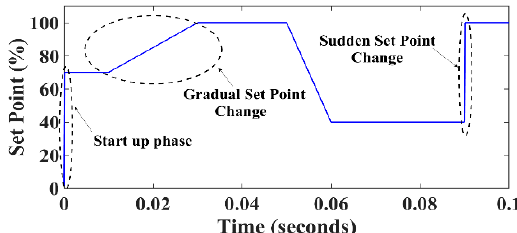
Figure 8. Global schematic of the proposed control method: ( a ) r1, r2, r3, and r4 relays are on; ( b ) r1 and r3 relays are on to activate the R-C filter effect; ( c ) r2 and r4 relays are on to deactivate the R-C filter effect.